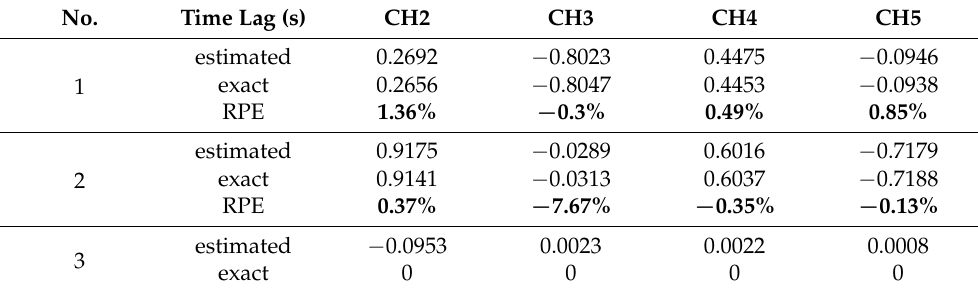
Table 2. Comparison between estimated and artificially misaligned time lags.